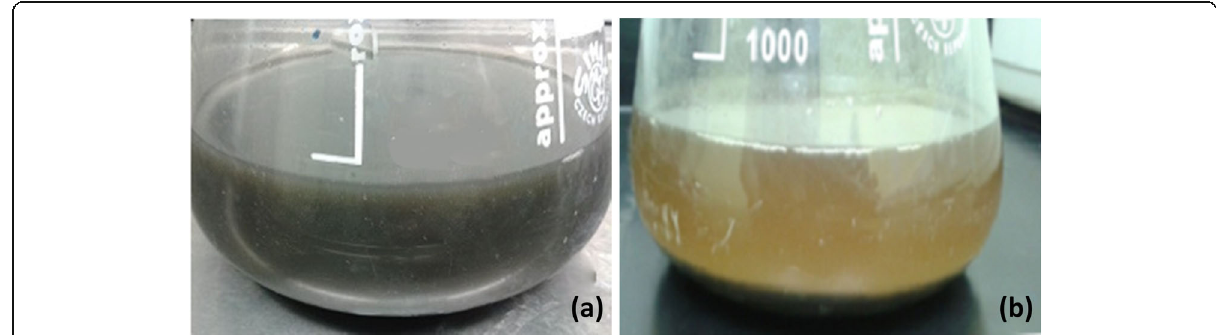
Fig. 1 Influence of indigenous microorganisms on maize processing wastewater ( a ) wastewater at the beginning of the test ( b ) at the